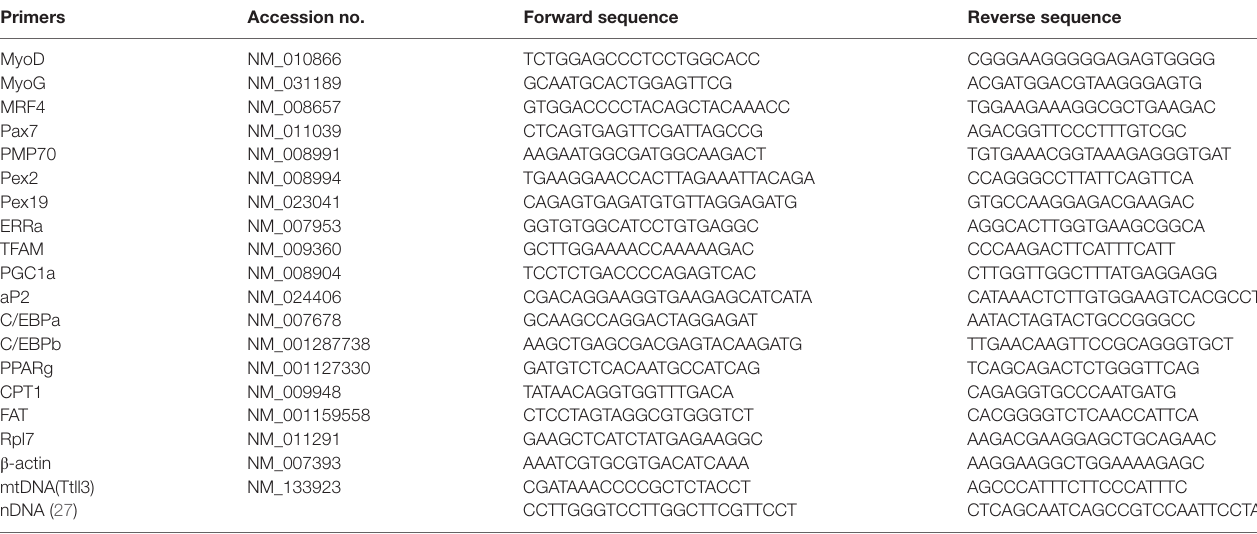
TaBle 1 | List of